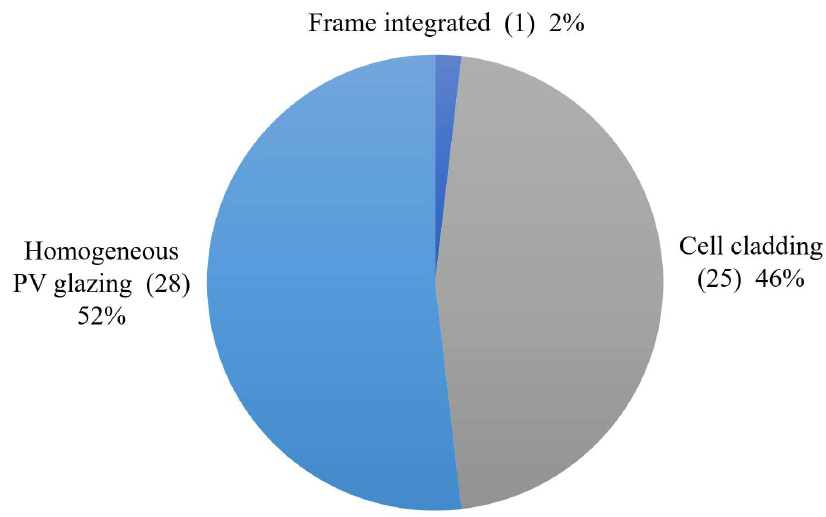
Figure 2. Numbers and percentages of research studies found for each type of ST-BIPV system.